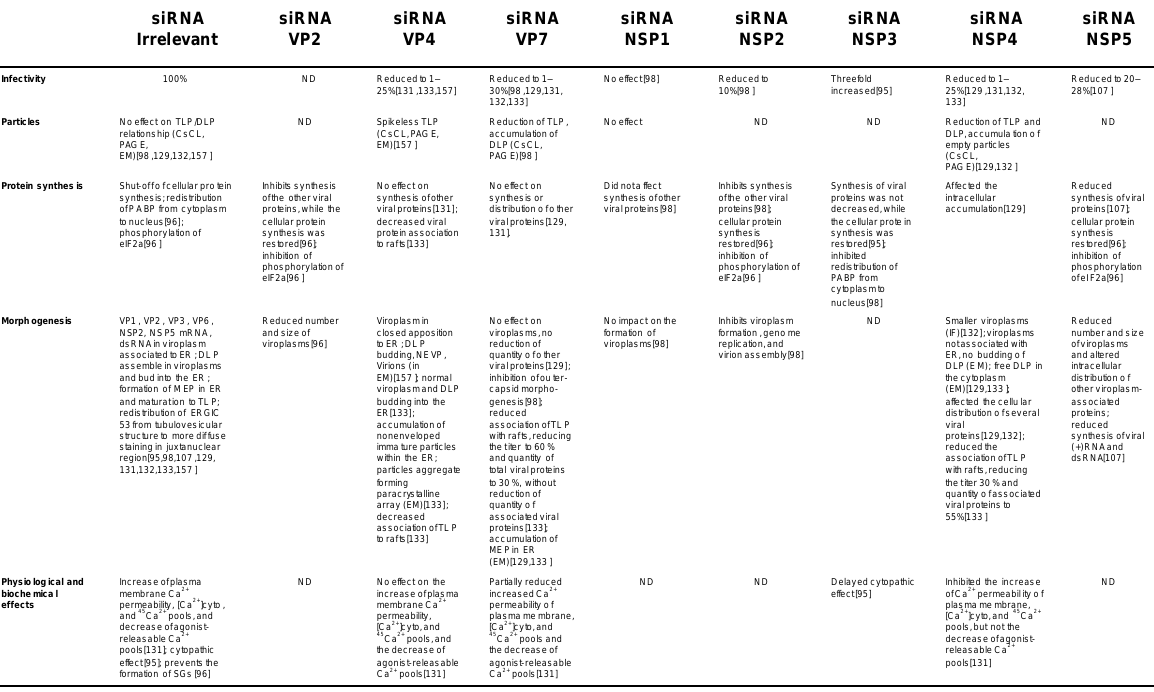
Effect of Silencing the Expression of Individual Viral Proteins on Infectivity, Protein Synthesis, Morphogenesis, and Physiology of Infected Cell